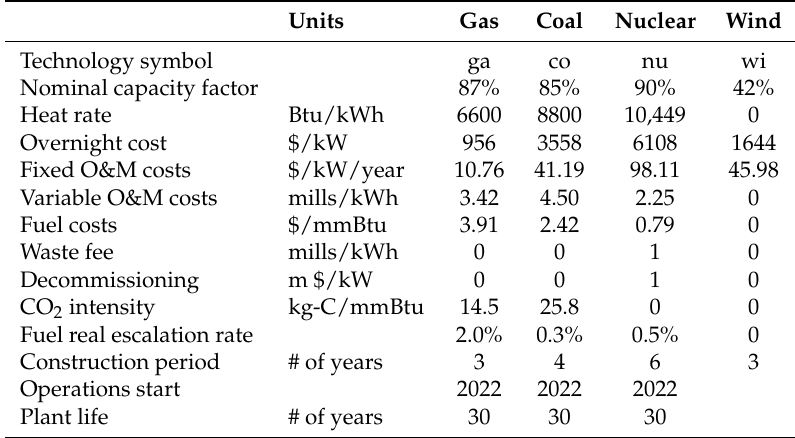
Table A1. Technical data and costs. All dollar amounts are in year 2015 dollars. Overnight costs are assumed to be uniformly distributed on the construction